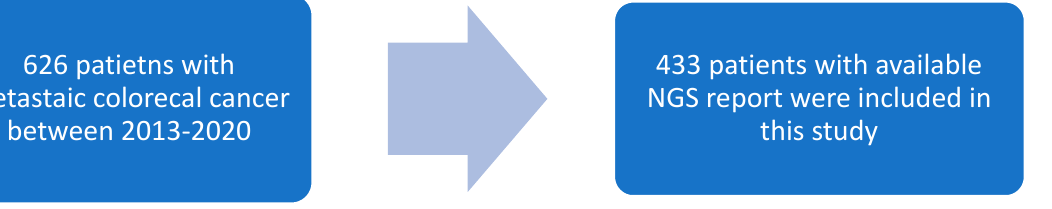
Figure 1. 626 patients with colorecal cancer was identified between 2013-2020. 433 of them had NGS report availabe therefore were eligible for this study.